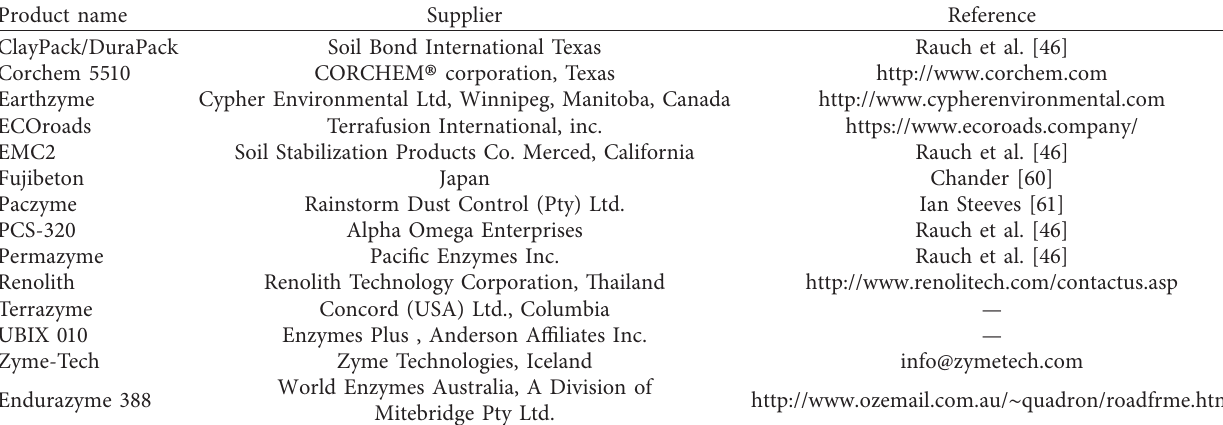
Table 1: List of commercially available soil stabilizer bioenzyme